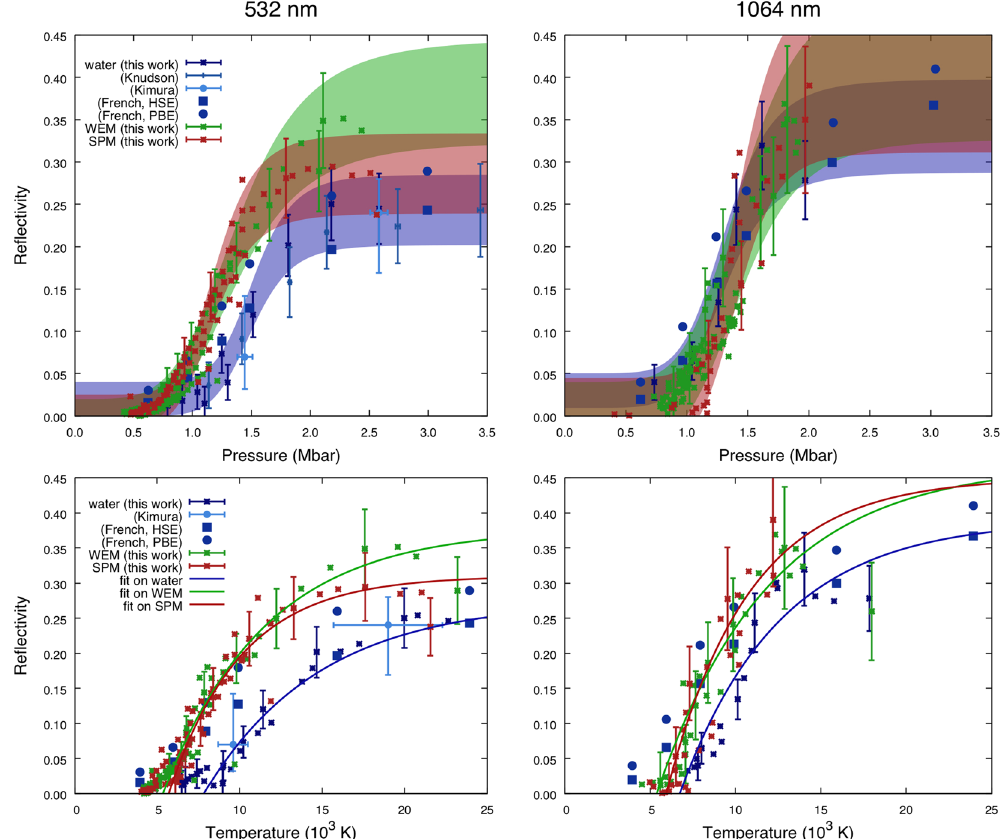
Figure 4. Reflectivity of water and the SPM at 532 nm (left) and 1064 nm (right) as a function of pressure (top) and temperature (bottom) along the principal Hugoniot curves. Top. Reflectivity vs pressure data. Blue, green, and red areas correspond to the fit of our data for pure water, WEM, and SPM within the error bars, respectively. Crosses are time-resolved measures during decaying shock propagation. Filled squares or circles correspond to previous DFT reflectivity calculations 55 using the HSE and PBE exchange-correlation functionals, respectively. Previous data on water are shown for comparison 26,27 . Error bars are larger at 1064 nm because of the smaller number of available shots. Bottom. Reflectivity vs temperature data. Solid lines serve as guides to the